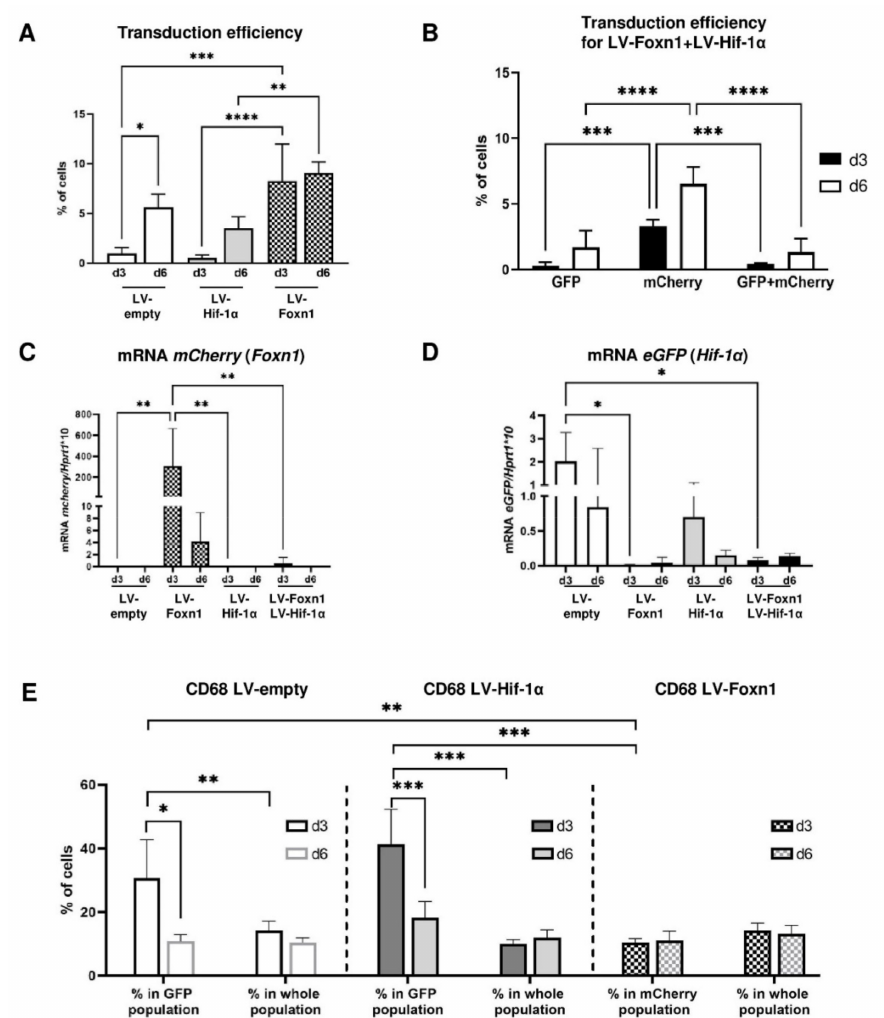
Figure 2. Transduction efficiency of lentivirus vectors (LVs) carrying Foxn1-mCherry, Hif-1 α -eGFP or eGFP (empty) injected into the wounded skin of Foxn1 − / − mice. Flow cytometry ( A , B , E ) analyses of cells isolated from the wounded skin at day 3 or day 6 ( n = 4 per time point/per group). Percentage of cells positive for eGFP or mCherry, isolated from the post-injured skin of ( A ) LV-empty-eGFP, LV-Hif-1 α -eGFP or LV-Foxn1-mCherry; ( B ) LV-Hif-1 α -eGFP+LV-Foxn1-mCherry injected Foxn1 − / − mice; mRNA expression of mCherry ( C ) or eGFP ( D ) in injured skin on days 3 or 6, collected from LV- empty-eGFP-, LV-Hif-1 α -eGFP, LV-Foxn1-mCherry- or LV-Hif-1 α -eGFP+LV-Foxn1-mCherry-injected mice. Percentage of CD68-positive cells within eGFP-positive (LV-empty or LV-Hif-1 α ) or mCherry- positive (LV-Foxn1) populations, in comparison to the whole cell population ( E ). Asterisks indicate significant differences (* p < 0.05; ** p < 0.01; *** p < 0.001; **** p < 0.0001). Data represents mean ±